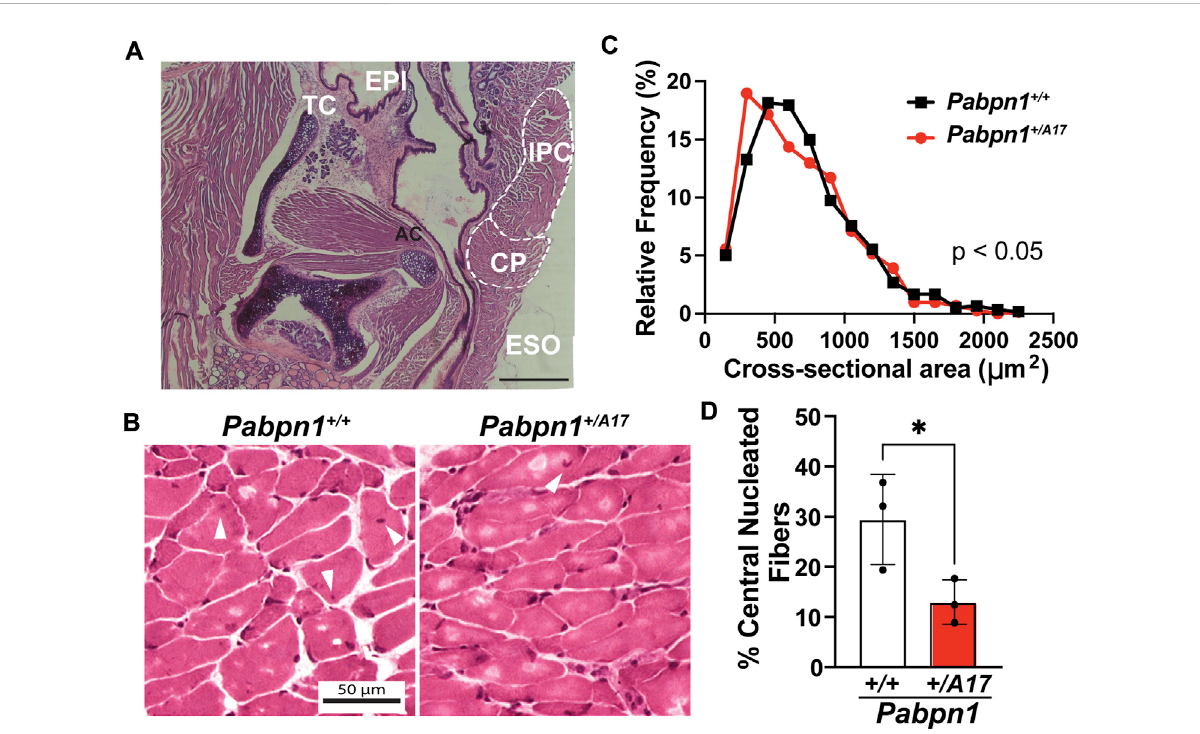
FIGURE 2 Pharyngeal muscles from Pabpn1 +/A17 mice contain smaller myo fi bers and evidence of impaired satellite cell function (A) Representative H&E- stained longitudinal section labeling anatomy of the laryngeal pharynx including cricopharyngeus (CP), esophagus (ESO), inferior pharyngeal constrictor (IPC), adenoid cartilage (AC), thyroid cartilage (TC), and epiglottis (EPI). Bar = 330 µm. (B) Representative H&E-stained CP muscle cross sectionsfrom Pabpn1 +/+ miceand Pabpn1 +/A17 mice.Whitearrowheadsmarkcentralnuclei.Bar=50 µm. (C) FrequencydistributionofCPcross sectionalarea(mm 2 )revealingasigni fi cantincreaseinsmall fi bersin Pabpn1 +/A17 mice.Shownisfrequencydistributionofbinnedcross-sectionalarea data from n = 3 mice per genotype. Statistical signi fi cance was determined using non-parametric Kolmogorov-Smirnov test. (D) Percentage of centralnucleated fi berswassigni fi cantlydecreasedin Pabpn1 +/A17 mice.Shownismean±SEMfor n =3mice.Statisticalsigni fi cancewasdetermined using Student ’ s t-test (* p <